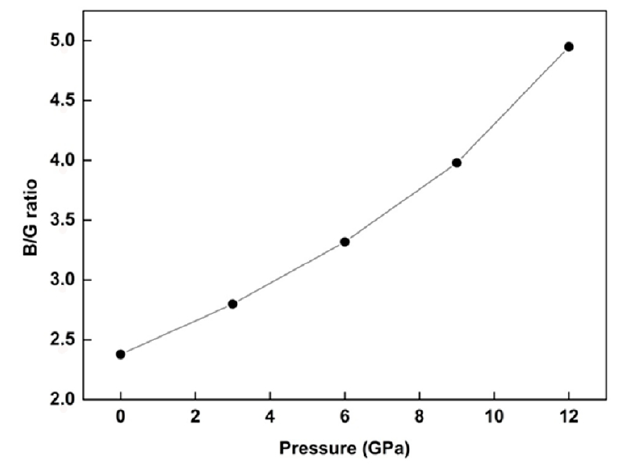
Figure 4. B/G ratio of WZ ZnS against